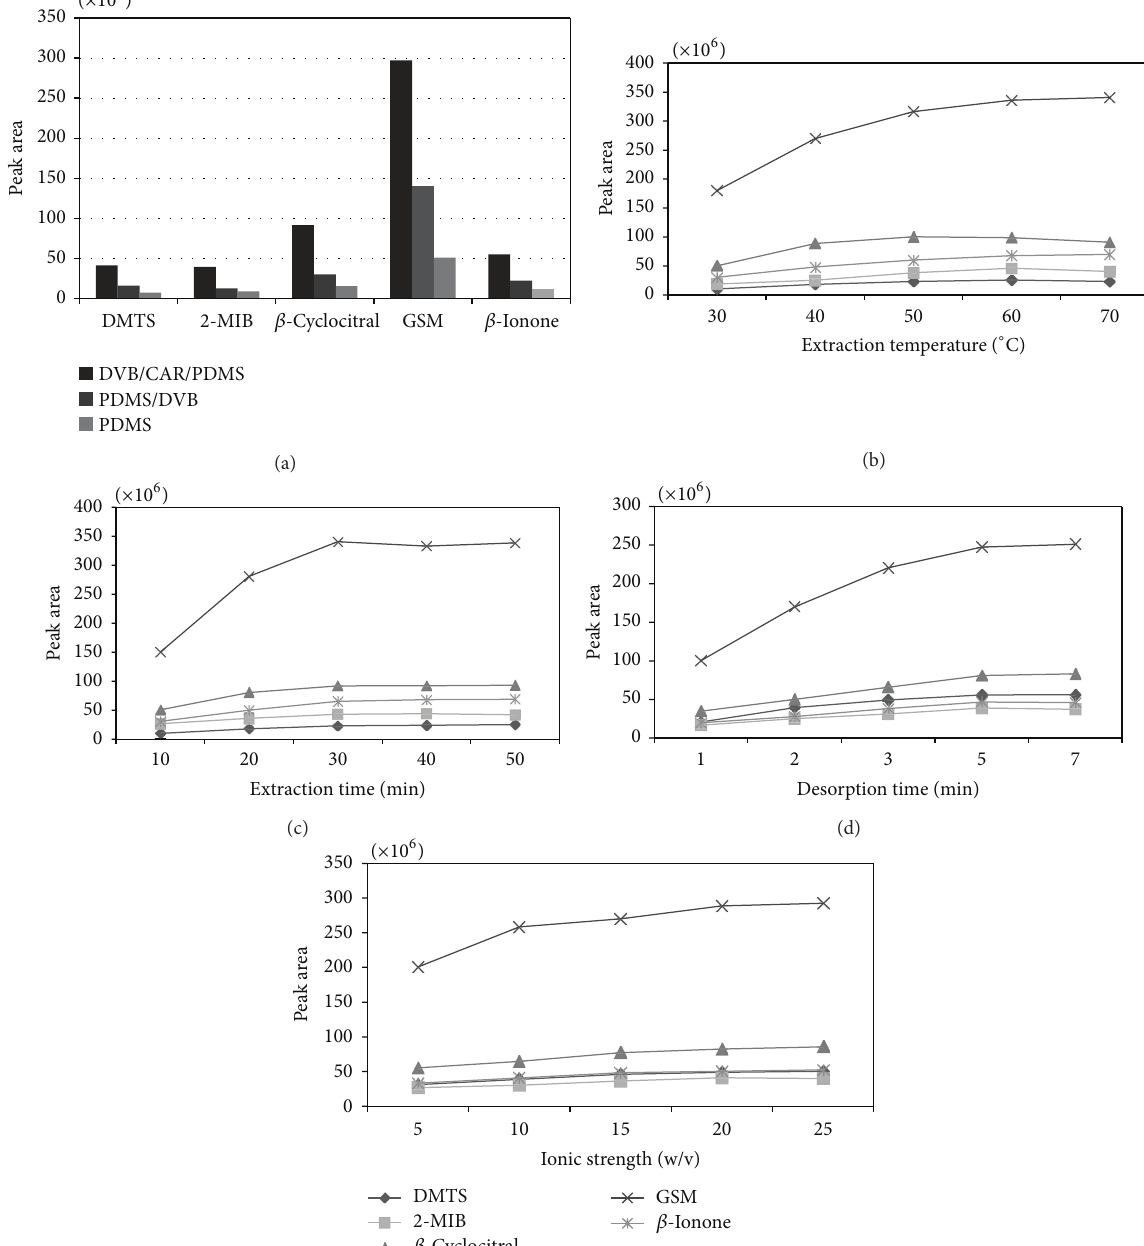
Figure 2: The effect of (a) fiber, (b) extraction temperature, (c) extraction time, (d) desorption time, and (e) ionic strength on the HS- SPME/GC-MS of five target compounds, and 100ng L −1 of mixed standard solutions was analyzed by (a) fiber exposition at 60 ∘ C, 30min, for 25% (w/v) ionic strength, (b) fiber exposition at 25% (w/v) ionic strength for 30min, (c) fiber exposition at 60 ∘ C for 25% (w/v) ionic strength, and (d) and (e) at 60 ∘ C for